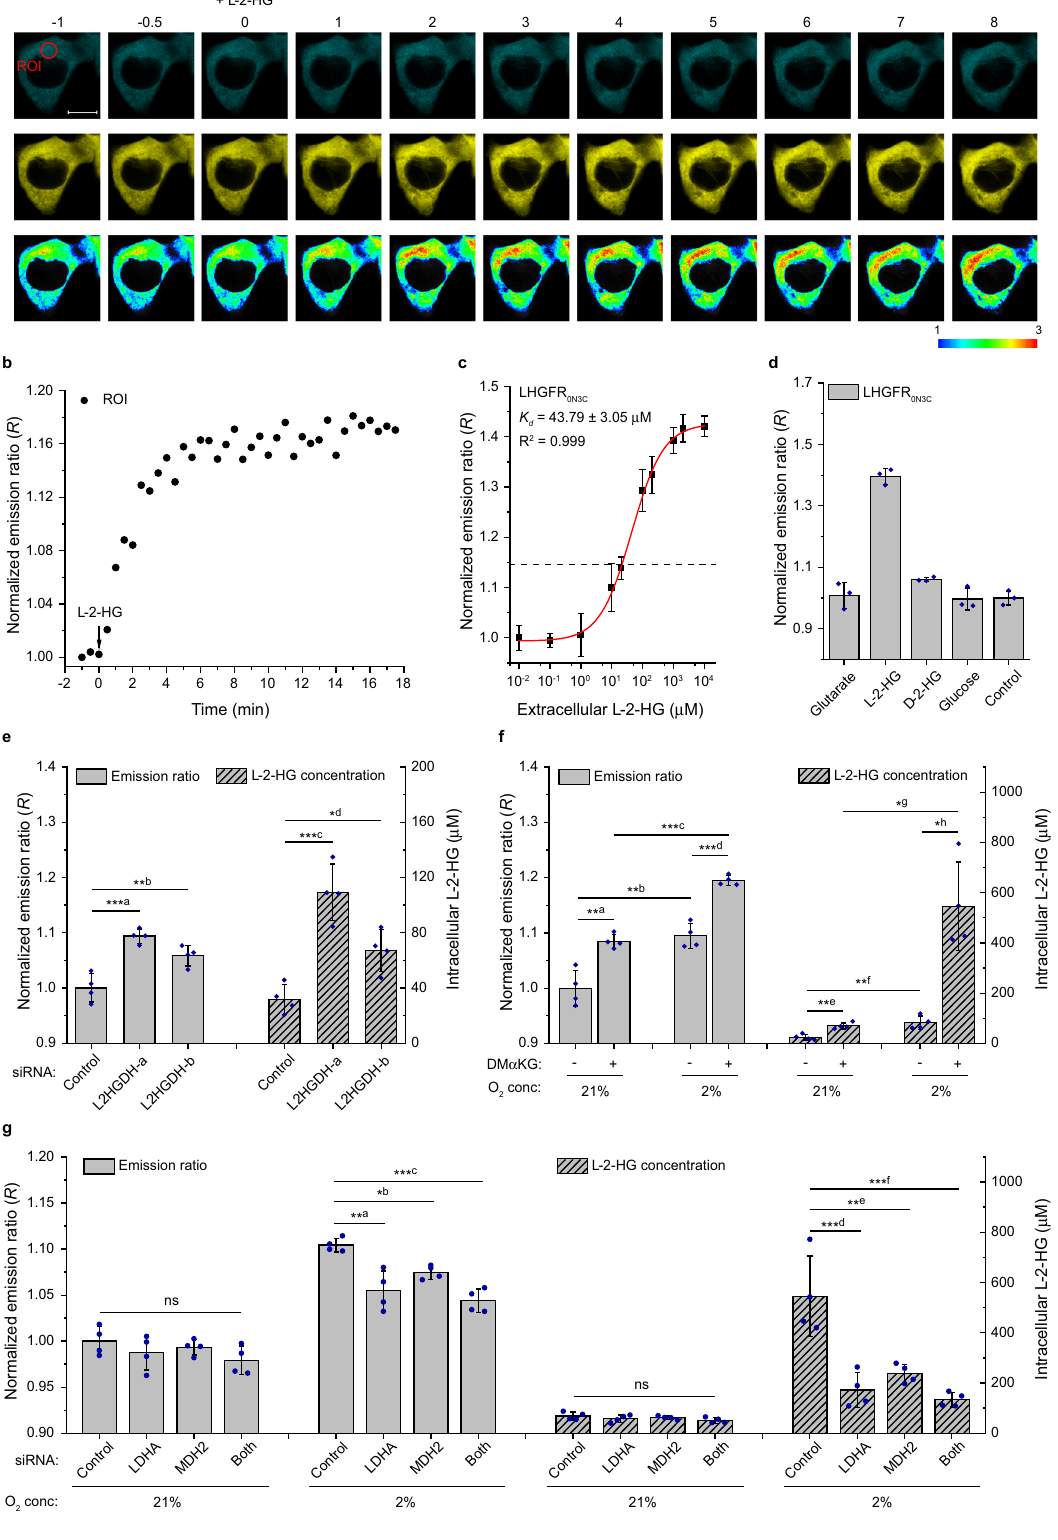
The performance of LHGFR 0N7C in monitoring L -2-HG fl uctuations in living HEK293FT cells was also studied and similar results were acquired (Supplementary Fig. 17). In addition, the emission ratio of control cells expressing LHGFR 3N7C remained unaffected by exogenous L -2-HG addition and hypoxia treatment (Supplementary Fig.